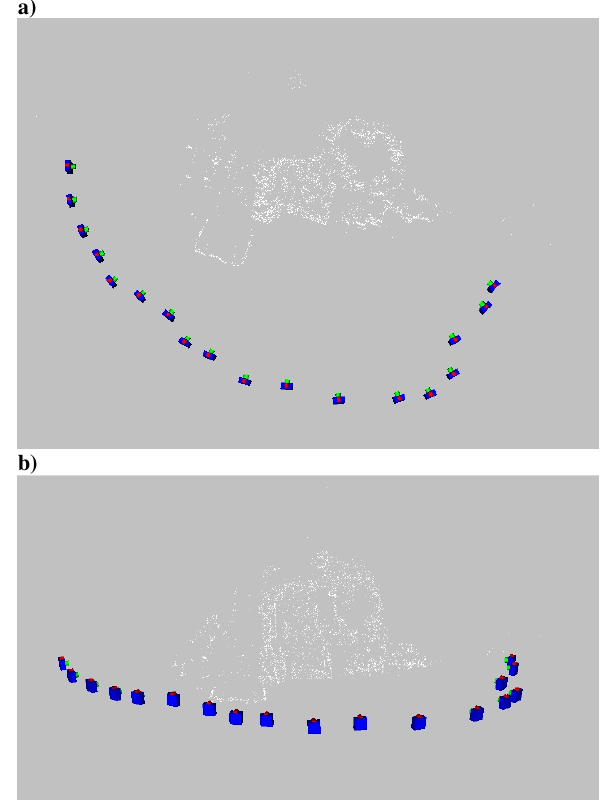
Figure 2. Orientation of Myson sequence: camera stations and tie points; a) top view; b) front view